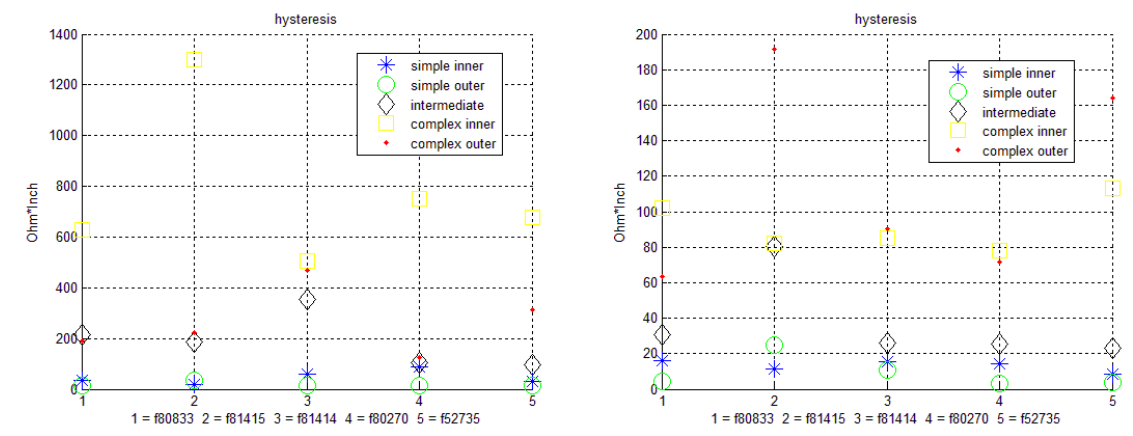
Figure 17. Hysteresis area: ( left ) un-insulated case; ( right ) insulated case.